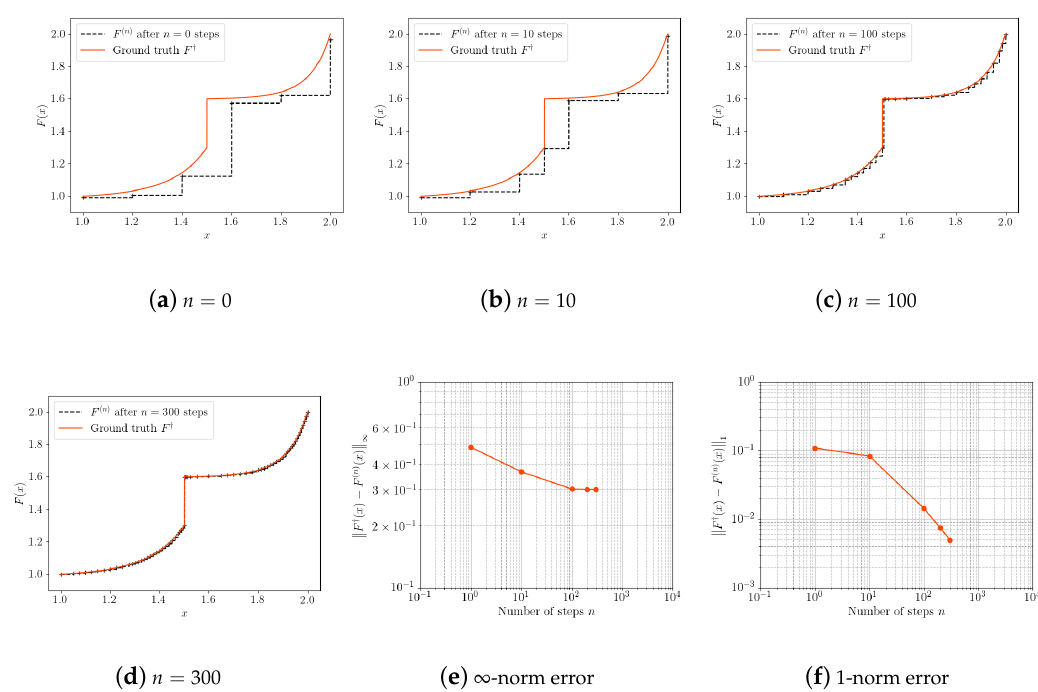
Figure 4. Evolution of F ( n ) and the ∞ - and 1-norms of the error F † − F ( n ) as functions of the iteration count, n , for a discontinuous ground truth F †